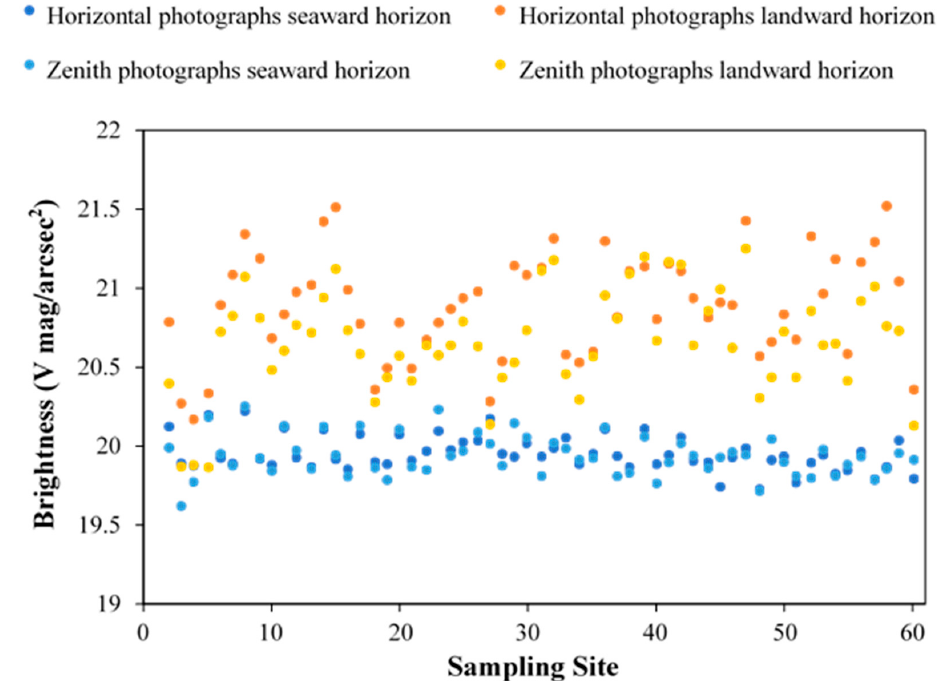
Figure 8. Average seaward horizon (shades of blue) and landward horizon (shades of orange) brightness (V mag / arcsec 2 ) at each sampling site as measured by the horizontal photographs’ cone of acceptance (COA) sector (dark blue and orange) and zenith photographs’ seaward and landward COA sectors (light blue and orange) under a combination of both moon conditions.